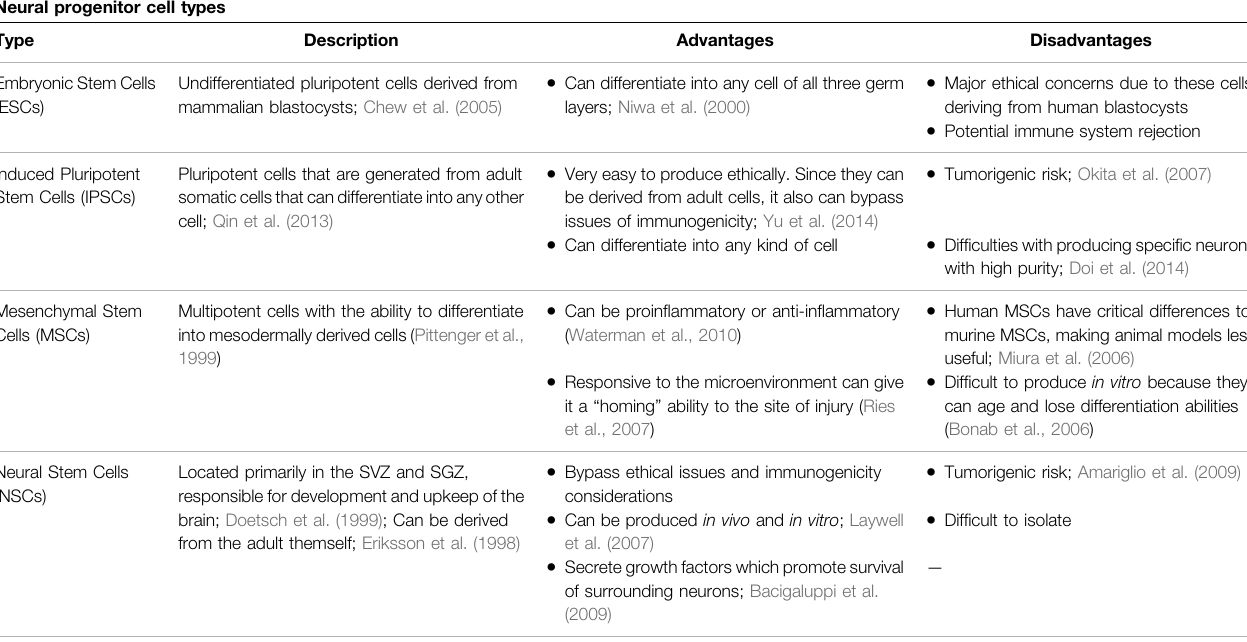
TABLE 2 | Common stem cells and neural-progenitor cell types used for the experimental treatment of ischemic stroke, Parkinson ’ s disease, and Huntington ’ s